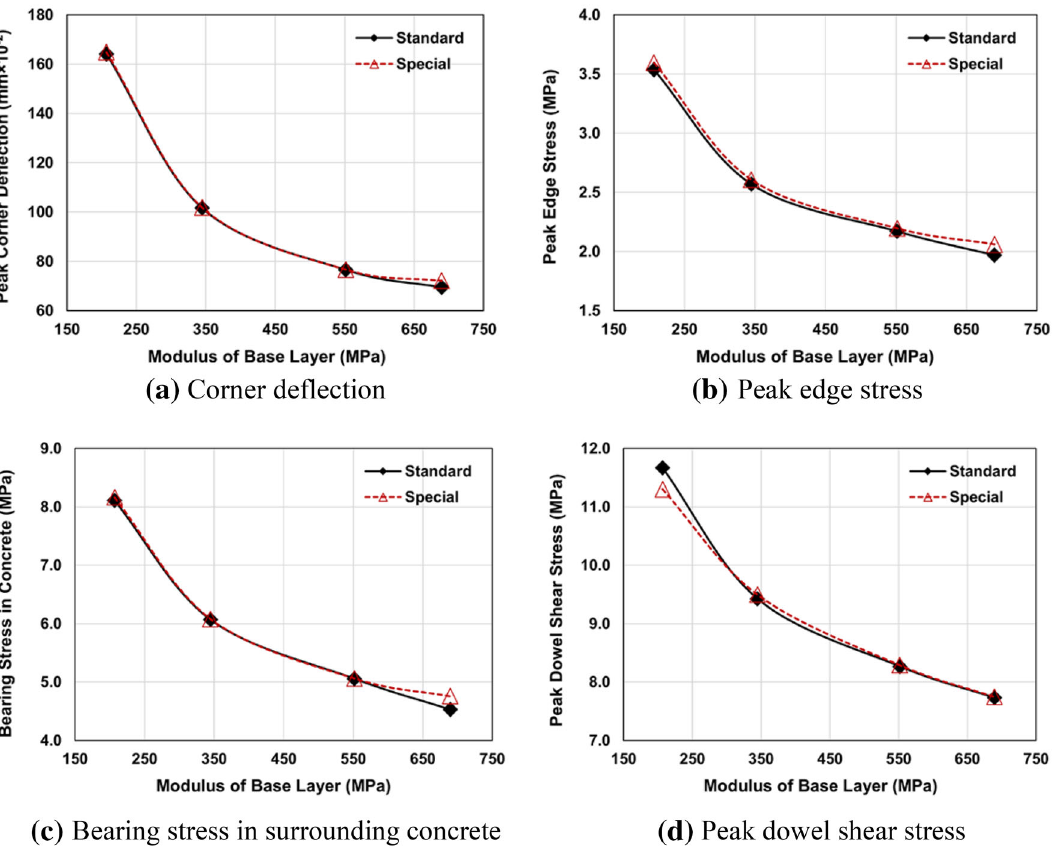
Fig. 13 Effects of base modulus on the dowel-joint